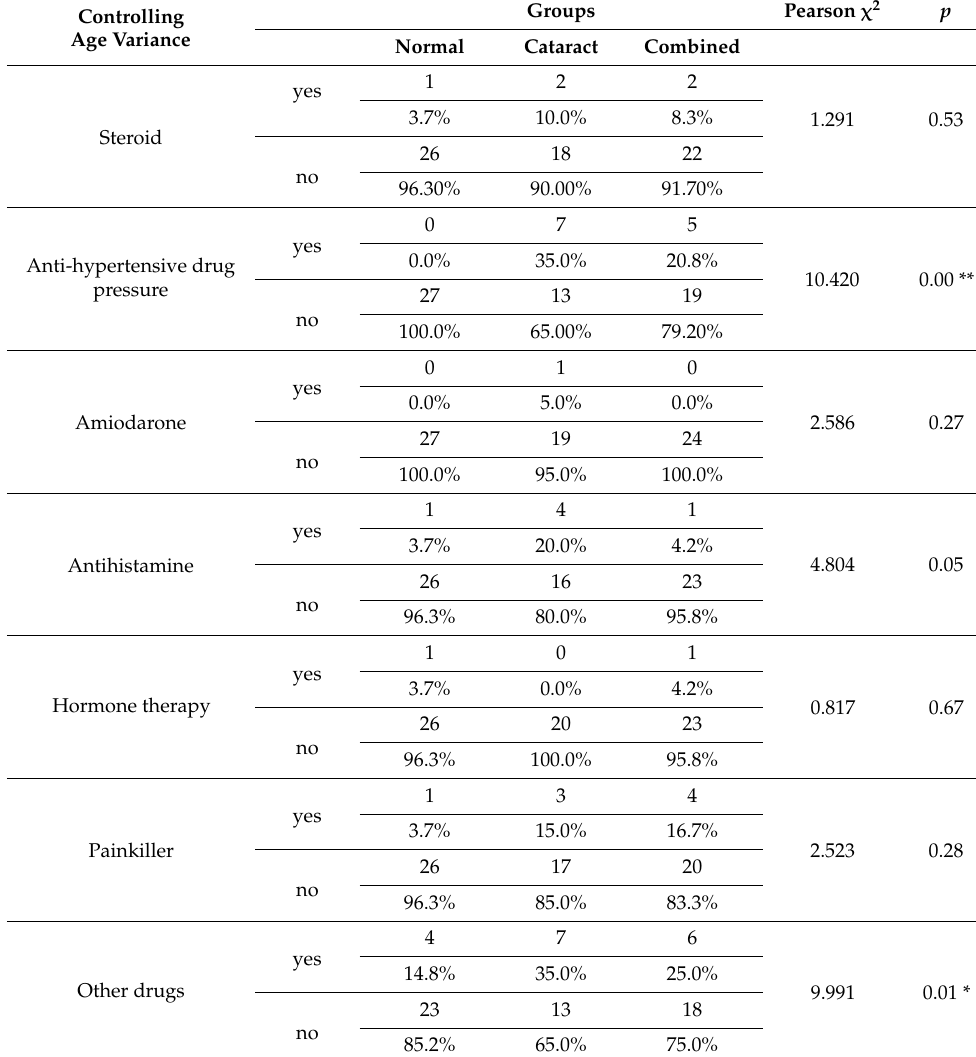
Table 3. Pearson χ 2 analysis on the health status between